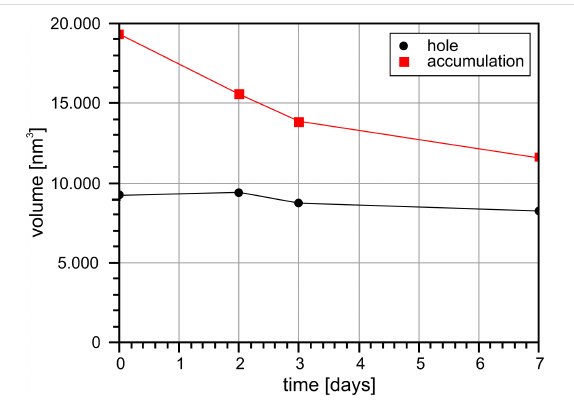
Figure 5: Volume of the hole and accumulation at 3.0% < RH < 5.5% within seven days. No significant change in the volume of the hole can be observed in this time period. The accumulation appears to be larger and show a higher material transport than the hole. However, these values are influenced by the tip–sample